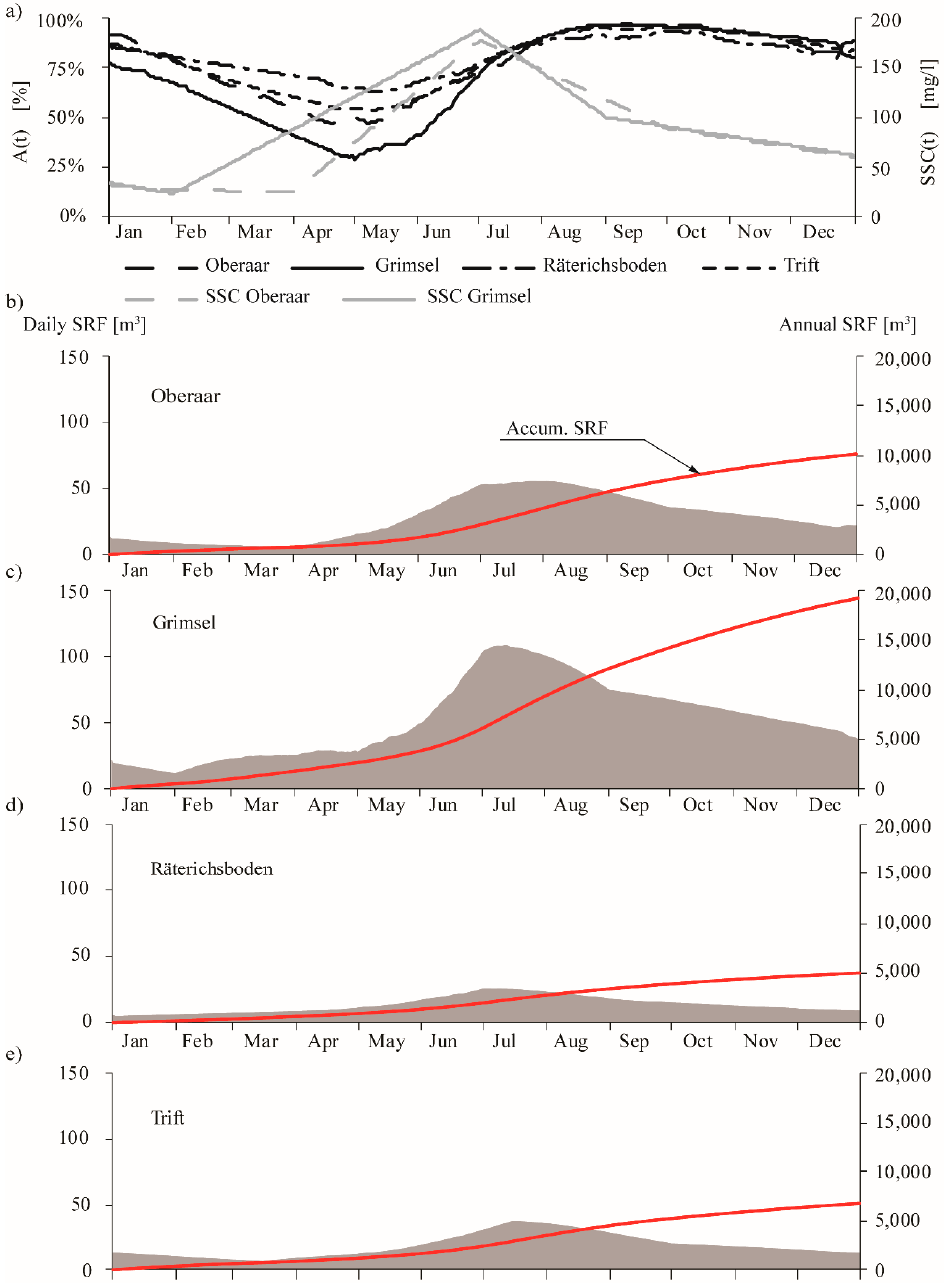
Figure 5. ( a ) Daily evolution of SSC in an average year for Oberaar and Grimsel, and daily evolution of A ( t ) for Oberaar, Grimsel, Räterichsboden, and Trift. ( b – e ) Daily evolution of SRF and accumulated values of SRF in an average year for Oberaar, Grimsel, Räterichsboden, and Trift, respectively.